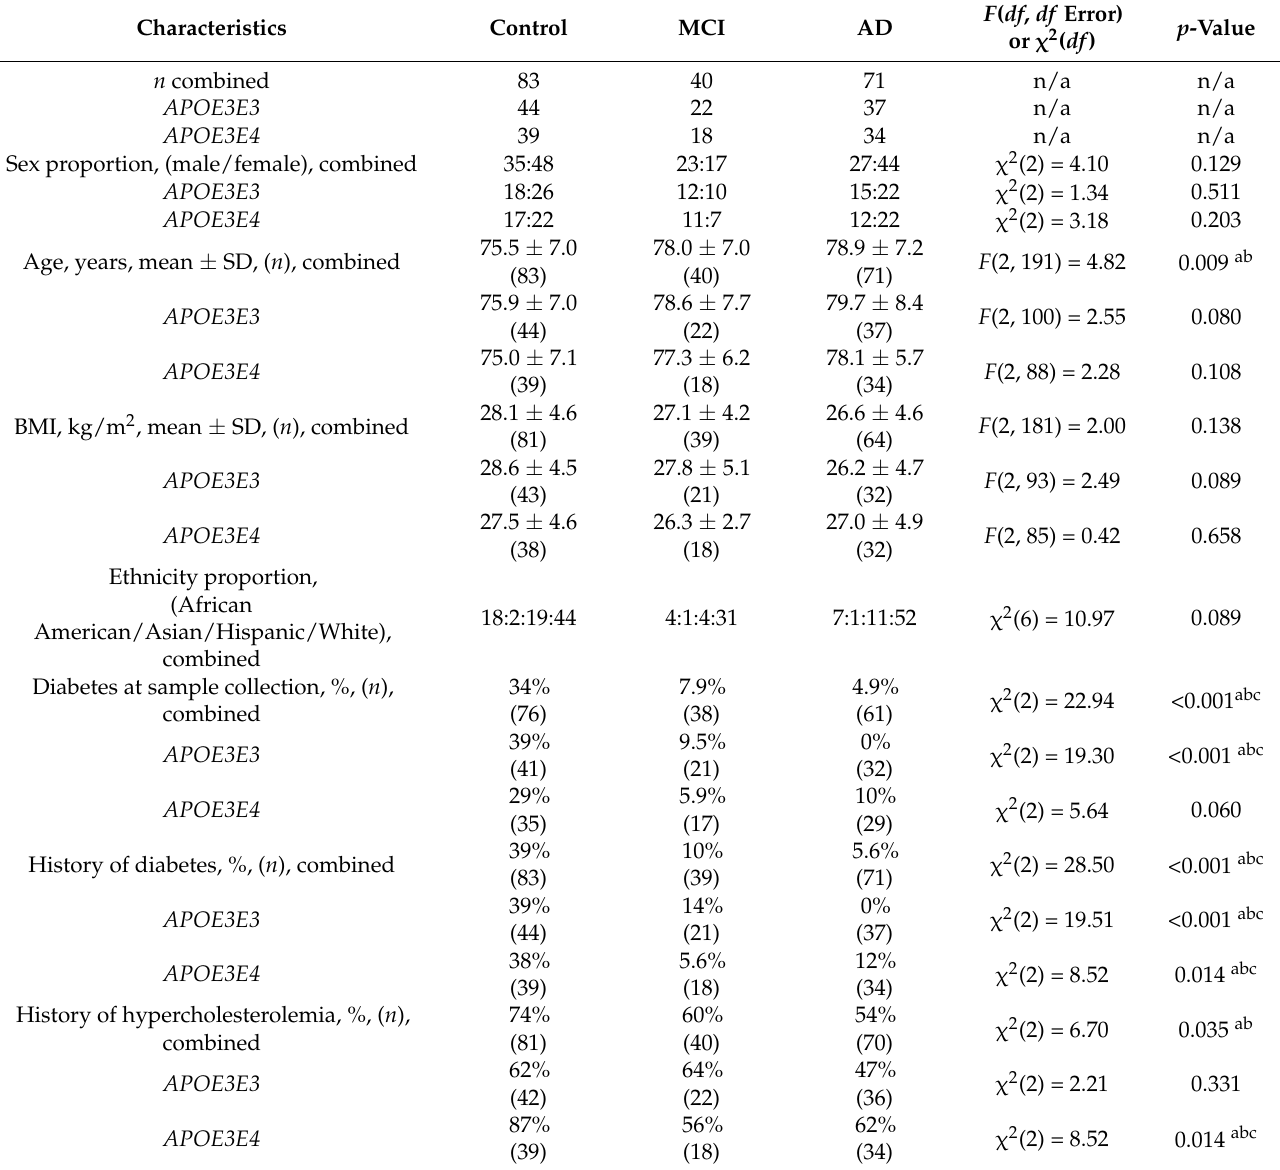
Table 1. Participant